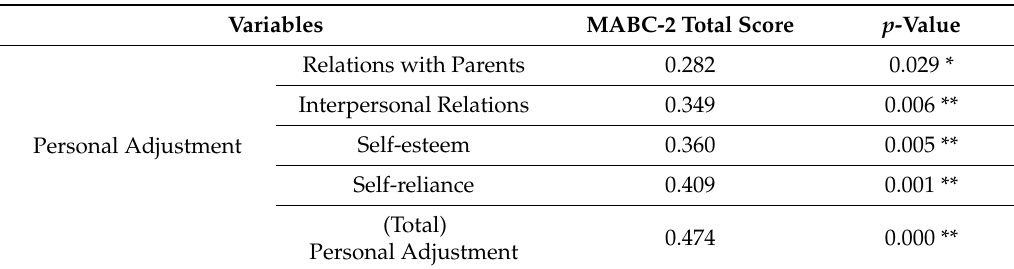
personal adjustment ( r = 0.474, p < 0.01), which are the behavioral problem criteria of the KBASC-2. Table 7. The association between motor coordination skills and behavioral